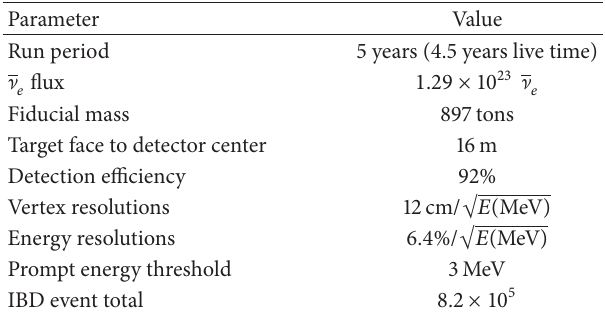
Table 2: The KamLAND detector parameters used in calculating the sterile neutrino search